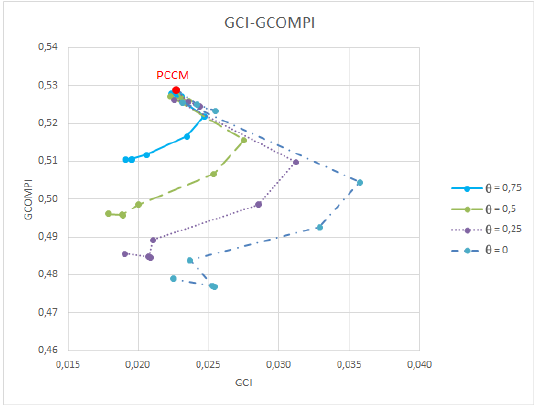
Figure 2. GCI and GCOMPI values for the iterative procedure (all the values of θ ).